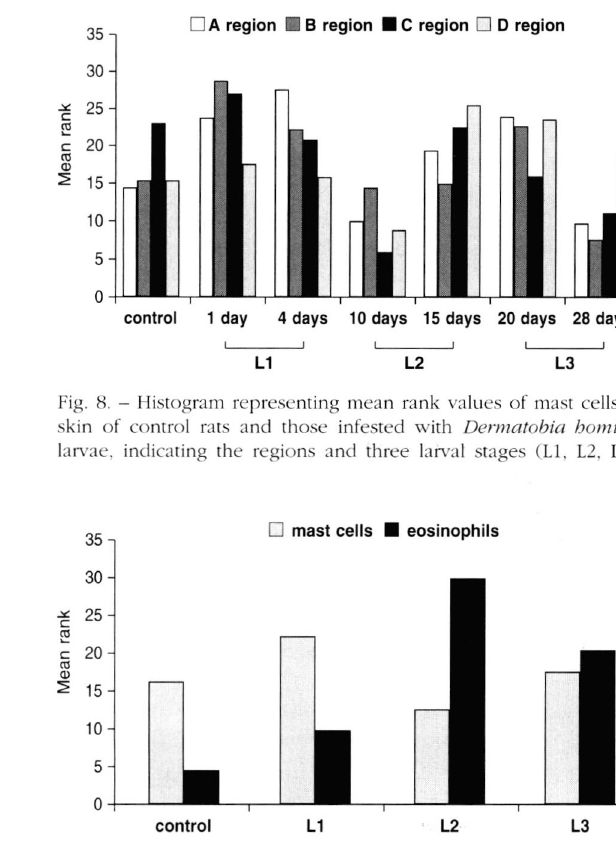
Fig. 9. - Relation between eosinophil and mast cell numbers in control rats and those infested with Dermatobia hominis larvae at different developmental